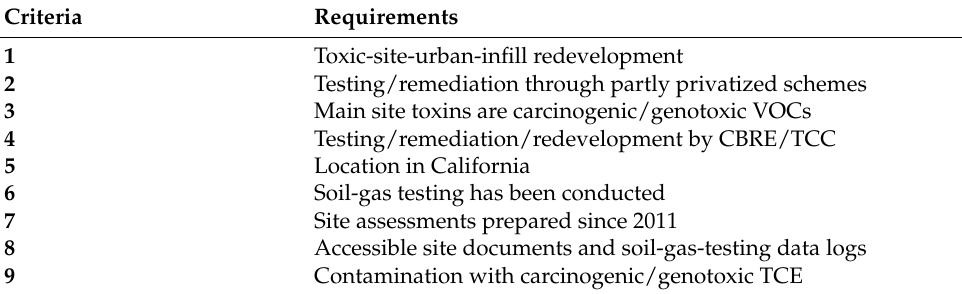
Table 1. Method 1 criteria for selecting which toxic-site assessments to evaluate.